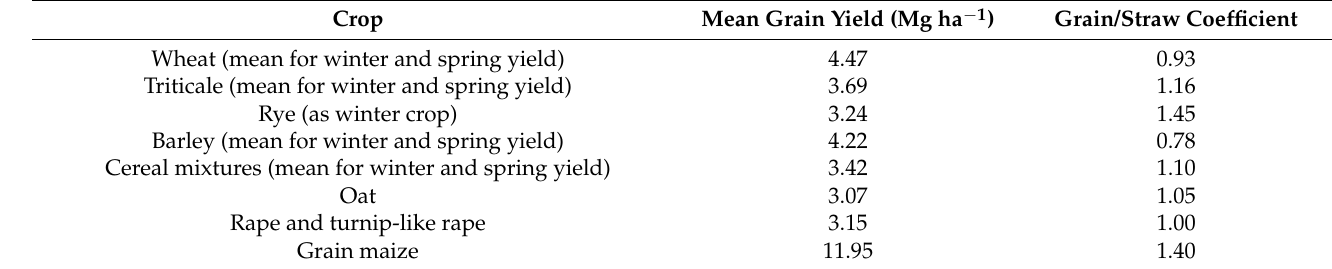
Table 3. Yield and grain/straw coefficient for